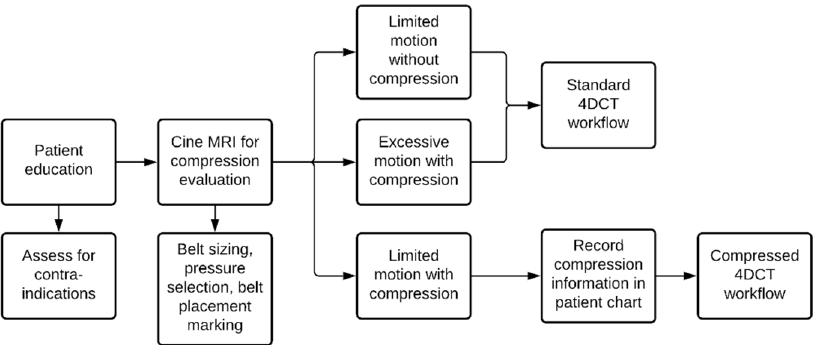
Figure 4. Compressed patient simulation workflow.